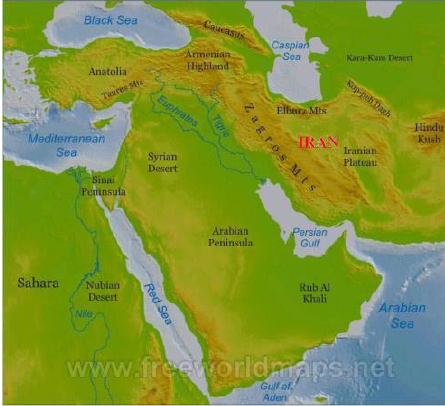
Figure 1. Geographical location of Iran in the middle east